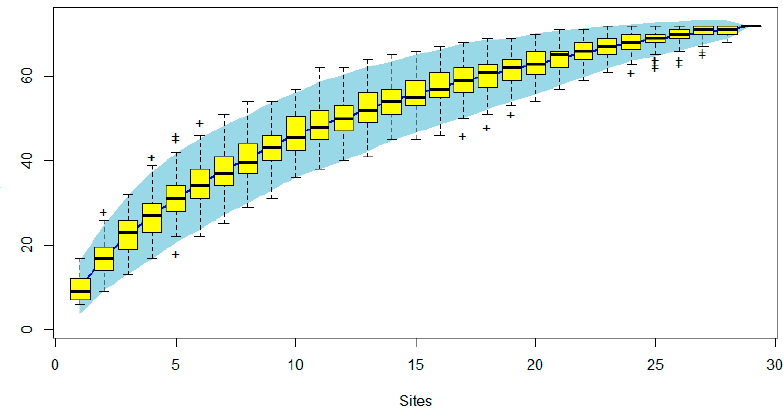
Figure 4. Estimated bird species richness rarefaction curve from 30 sites sampled in three disturbance levels urban mountain parks in Fuzhou, China. The colored area indicates 95% confidence intervals. “+, ‡” stands for an outlier of the box plot. The curve tends toward asymptote, indicating sufficient sampling effort in the whole site.